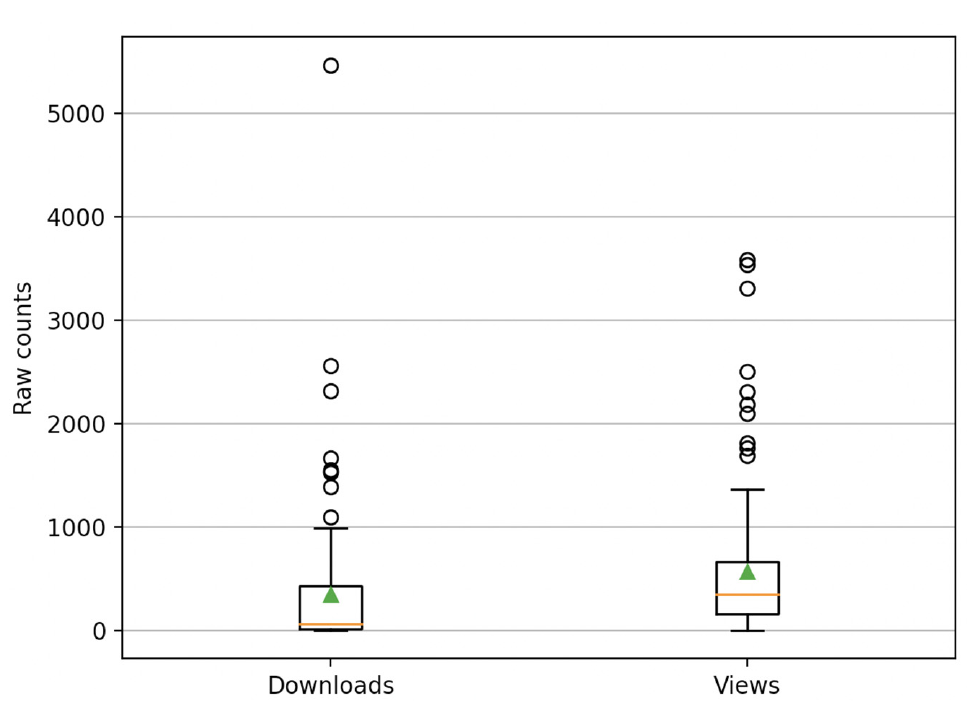
Figure A4. JOHD/RDJ data papers: average downloads and views.